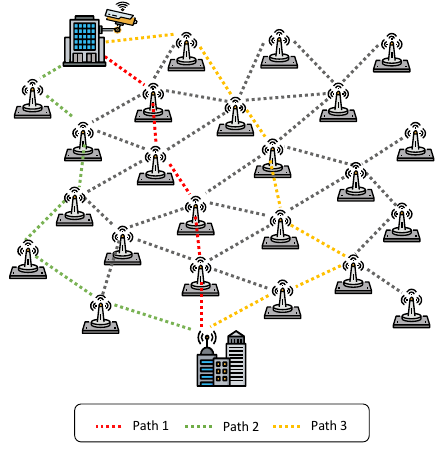
Figure 8. Paths used for